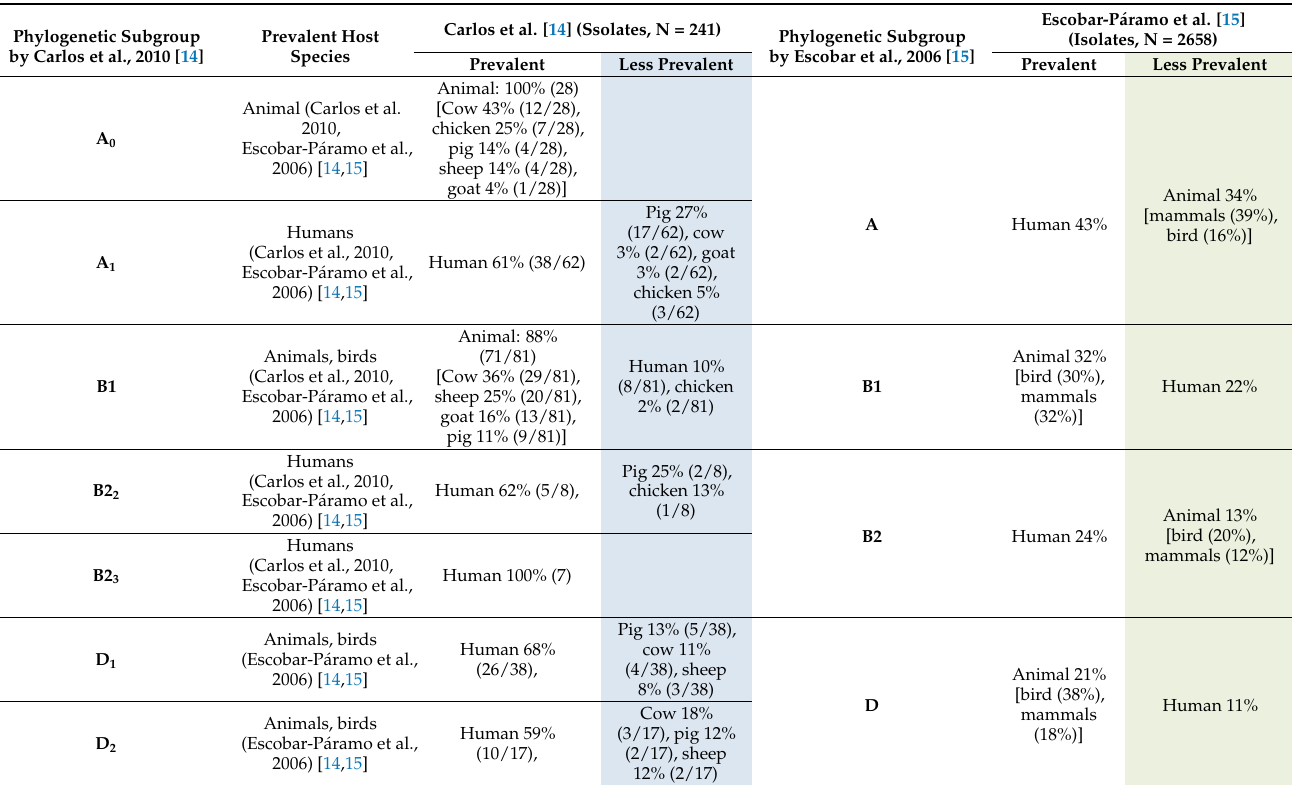
á ramo et al. [15] (Isolates, N = 2658)Phylogenetic Subgroup